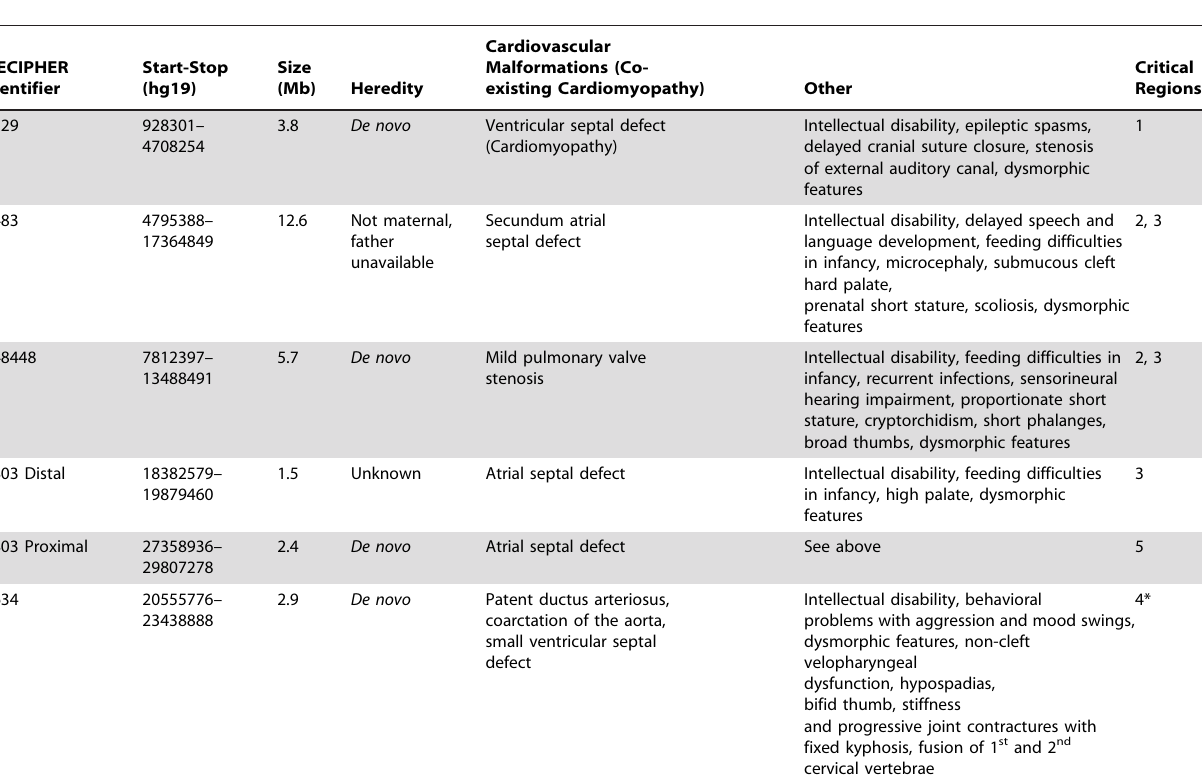
Table 2. Summary of individuals with isolated 1p36 deletions and cardiovascular malformations identified from the DECIPHER